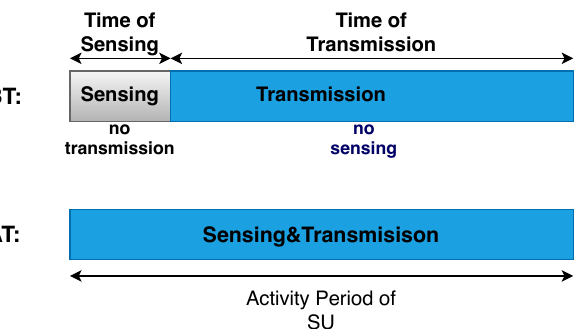
Figure 2. The two main functioning modes of SU activity. Listen-before-Talk (LBT): SU remains silent during the sensing period and no sensing is performed during the transmission. Listen and Talk (LAT): sensing and transmission are made